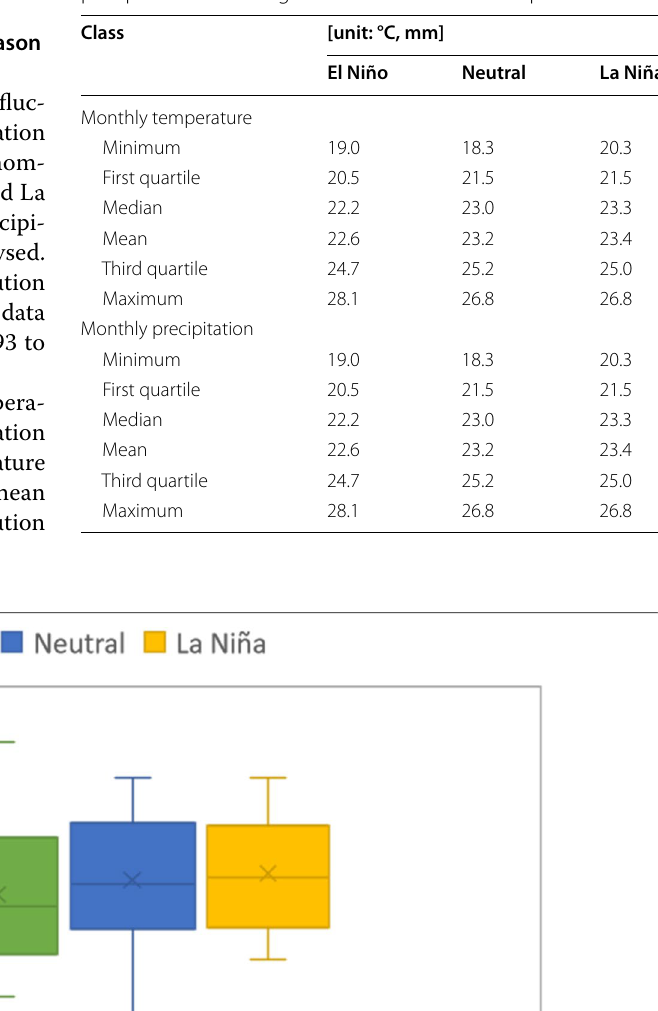
Table 3 Distribution of the monthly temperature and precipitation according to the classification of the